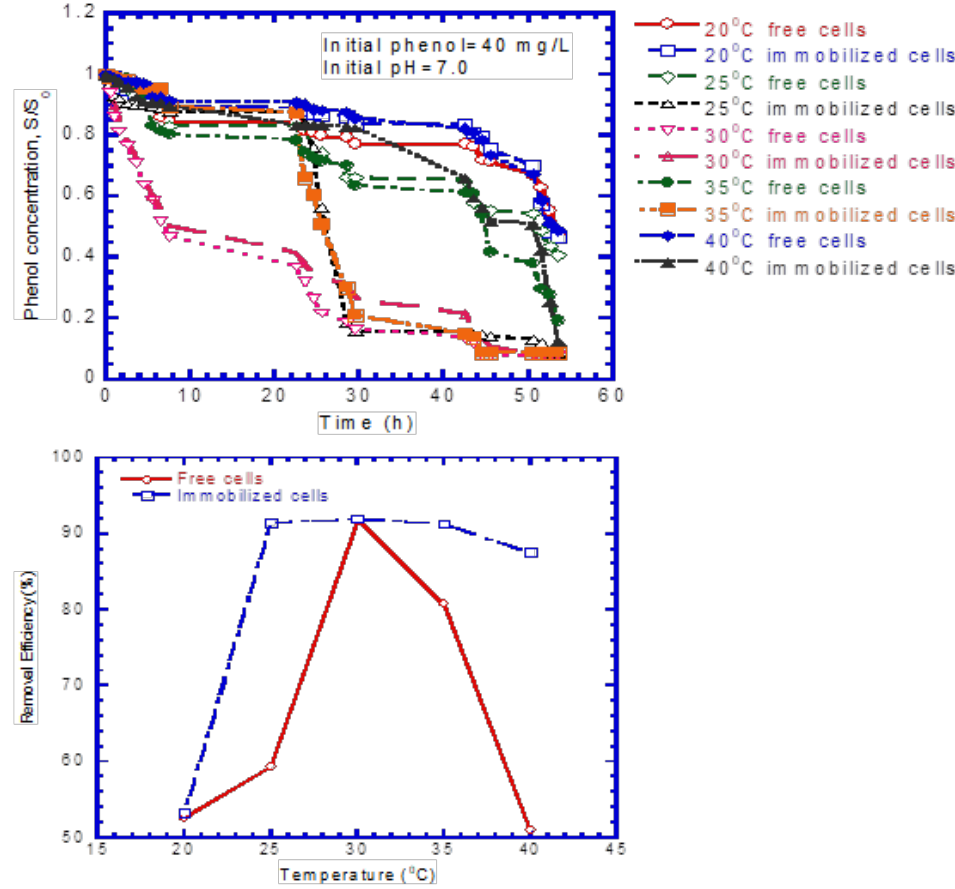
Figure 4. Effect of temperature on phenol degradation by free and immobilized cells. Figure 4. E ff ect of temperature on phenol degradation by free and immobilized